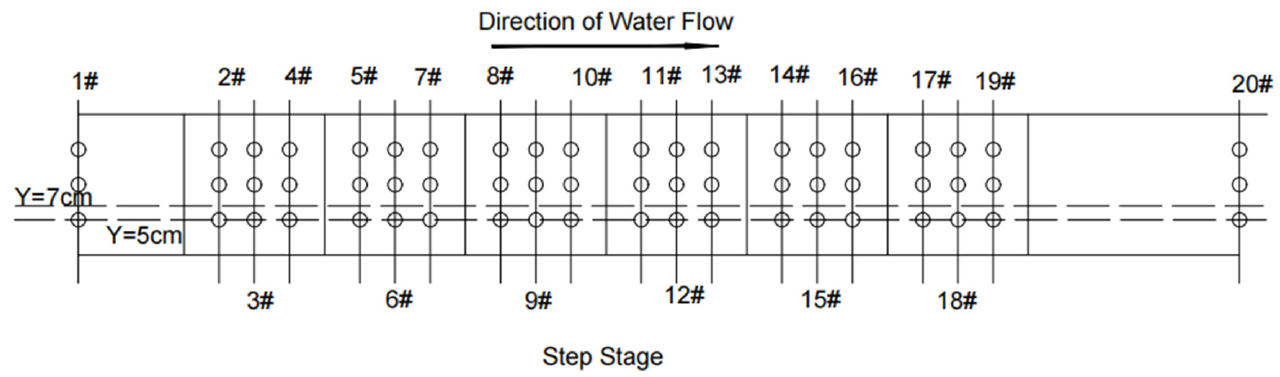
Figure 5. Schematic layout of measurement points.